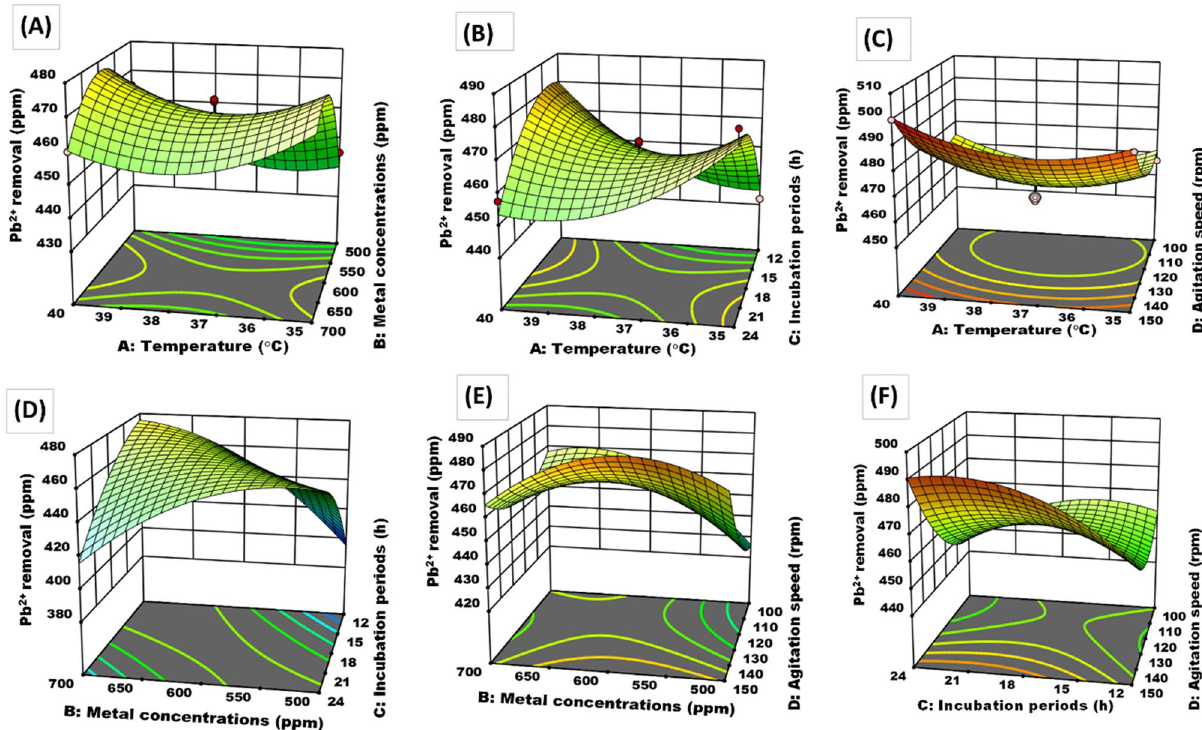
Figure 5. Three-dimensional response surface and two-dimensional contour plots Pb 2+ metal removal by 17OS strain showing variable interactions of ( A ) Temperature degree vs. metal concentration, ( B ) Temperature degree vs. incubation periods, ( C ) Temperature degree vs. agitation speed, ( D ) metal concentration vs. incubation periods, ( E ) metal concentration vs. agitation speed and ( F ) incubation periods vs. agitation